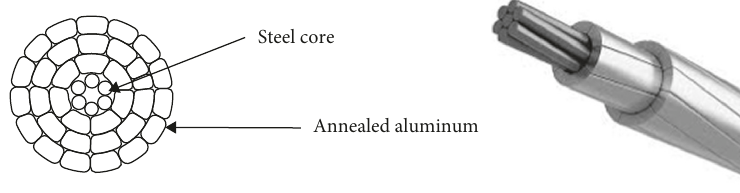
Figure 5: ACSS/TW